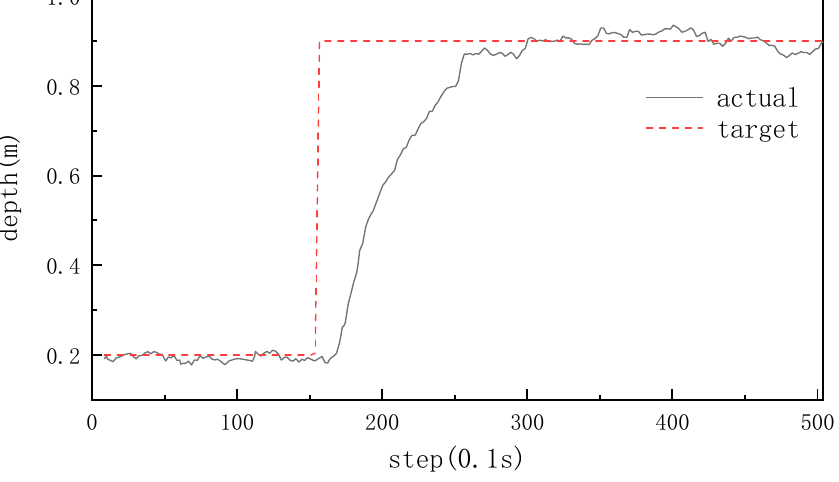
Figure 16. Automatic control of the depth.